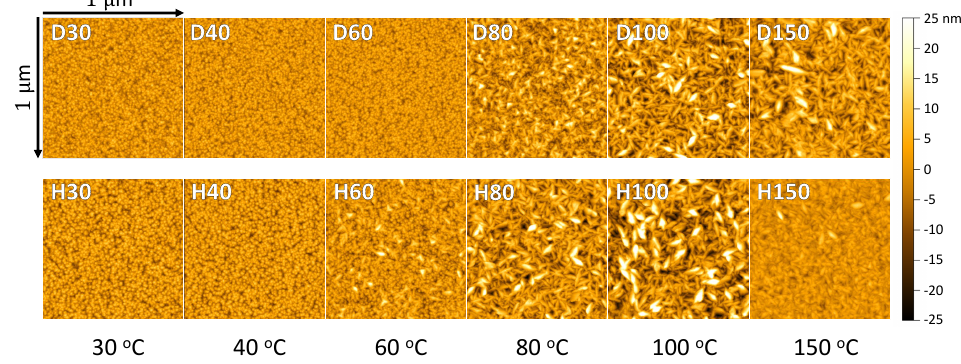
Figure 3. AFM micrographs of ZnO films deposited with DEZ and either 1 H 2 O or 2 H 2 O at different temperatures. The preferred crystal orientation changes as the temperature is raised. The lengths of the sides in each image are 1 µ